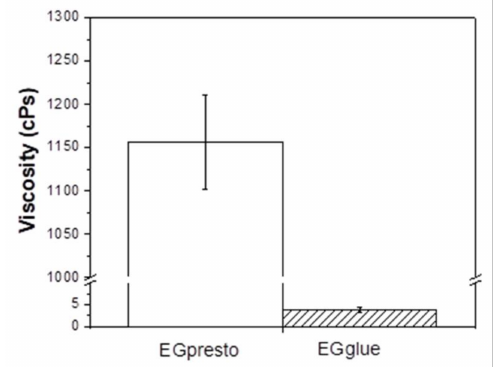
Figure 2. Viscosities of EGglue and EGpresto measured at 25 ◦ C. The respective viscosity values were averaged from three independent measurements, and the calculated results were 3.7 ± 0.6 cPs for EGglue and 1150 ± 55 cPs for EGpresto ( p < 0.005). Statistical analysis method: Student’s t